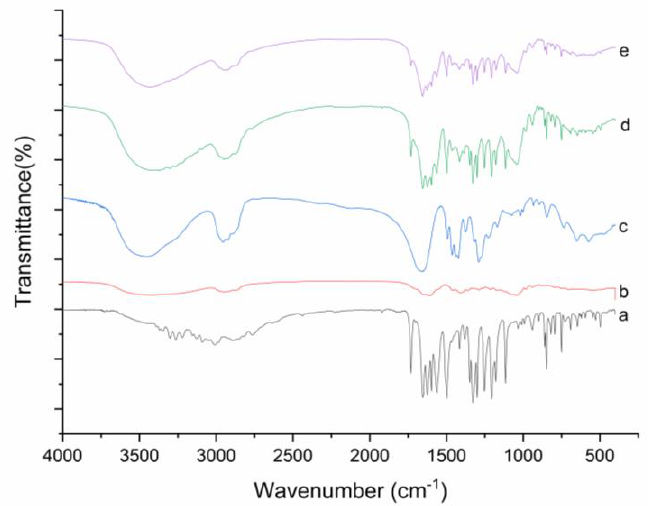
Figure 4. FT-IR spectra of ( a ) DNC, ( b ) GA, ( c ) PVP K30, ( d ) DNC/GA/PVP K30 SD, and ( e ) DNC/GA/PVP K30 SD.